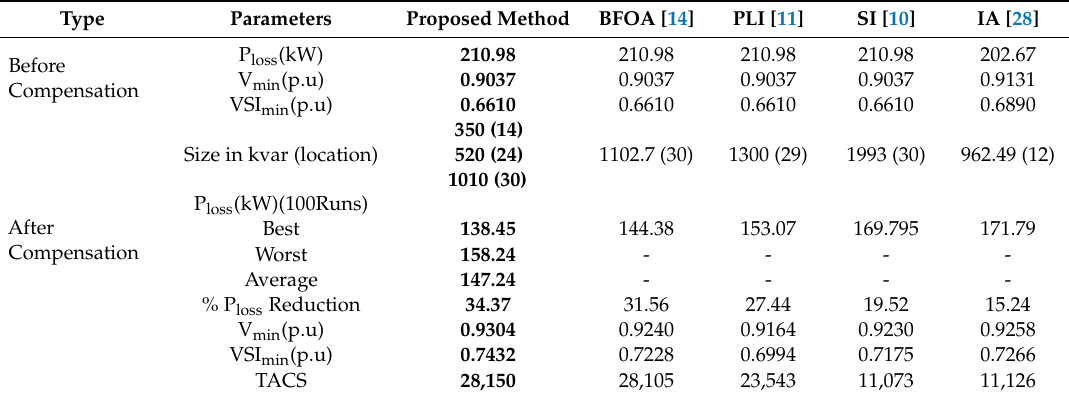
Table 2. Results of 33-bus system (Constant